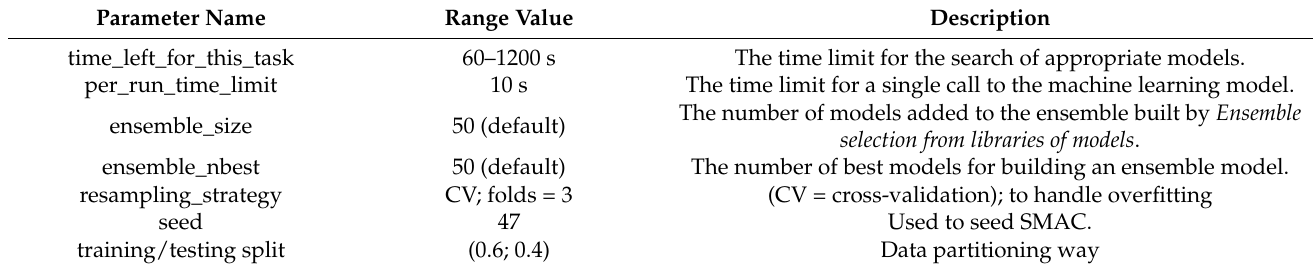
Table 2. The AutoML main parameters and descriptions used in this